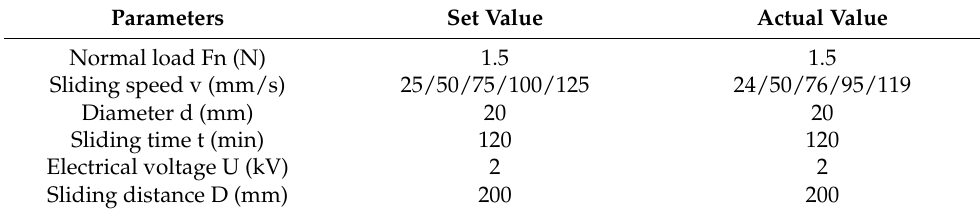
Table 1. Parameters of testing